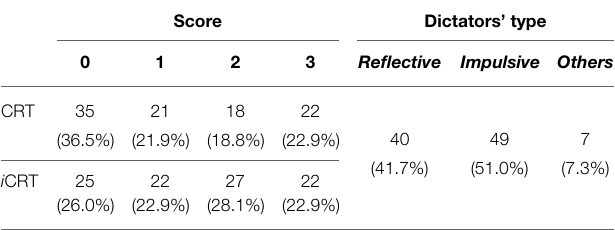
TABLE 1 | CRT, iCRT, and Dictators’ types. Score Dictators’